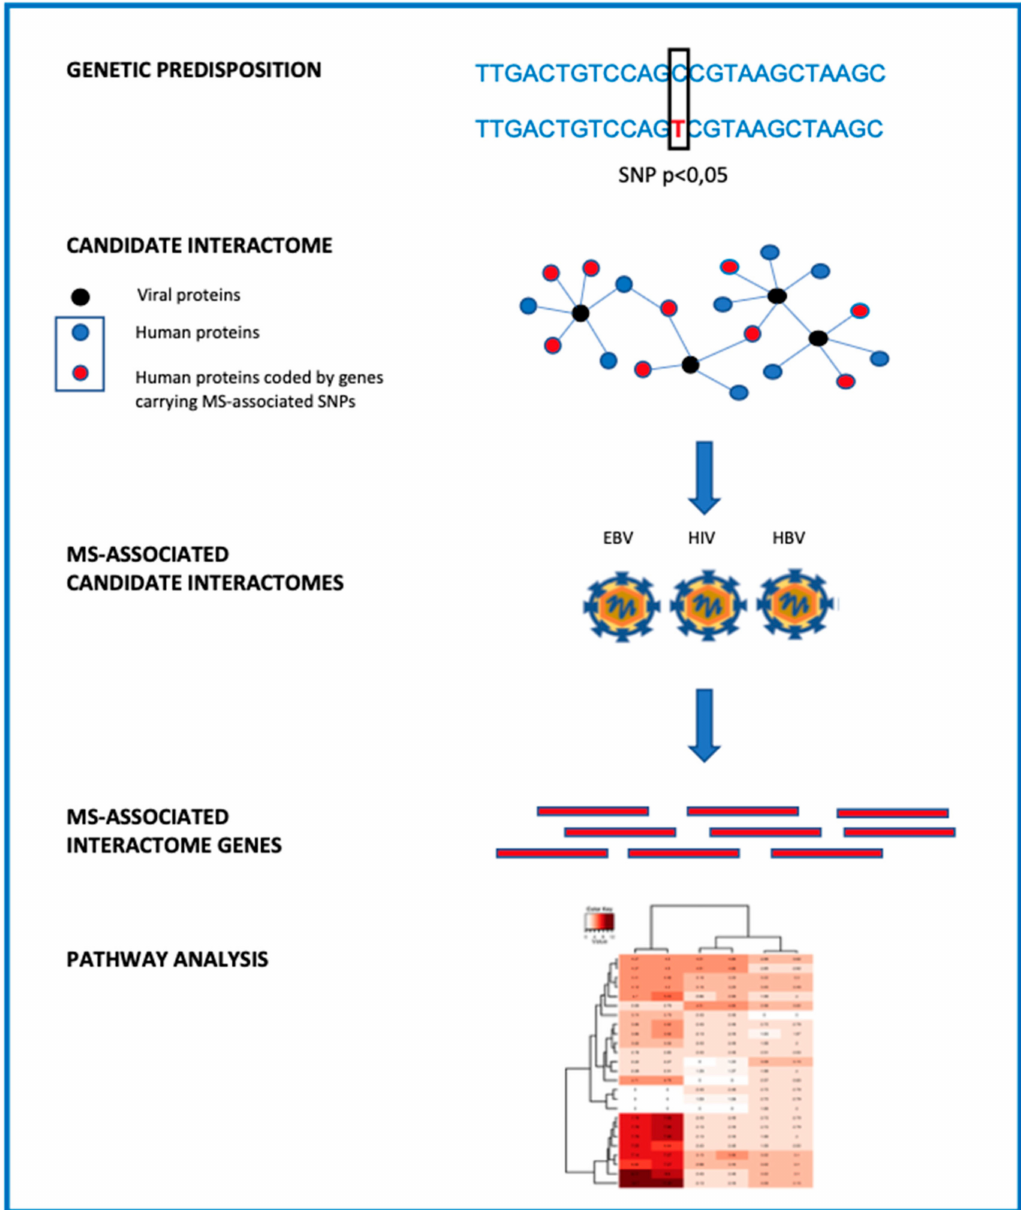
Figure 1. Schematic representation of the candidate-interactome